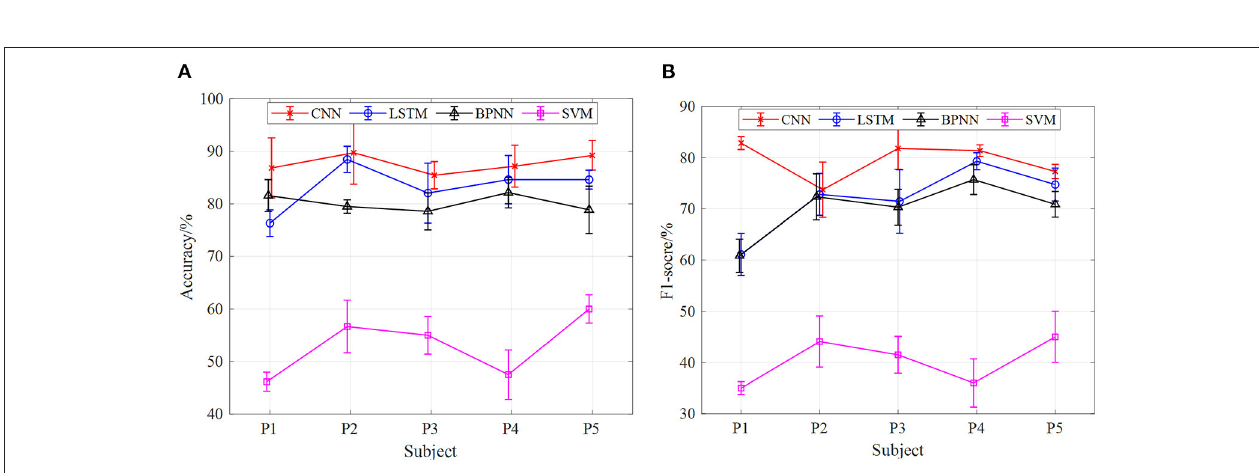
Frontiers in Neurorobotics | www.frontiersin.org